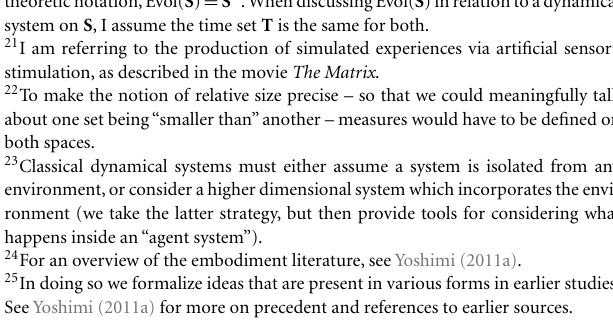
a total system or environmental system e which contains that agent as a part 26